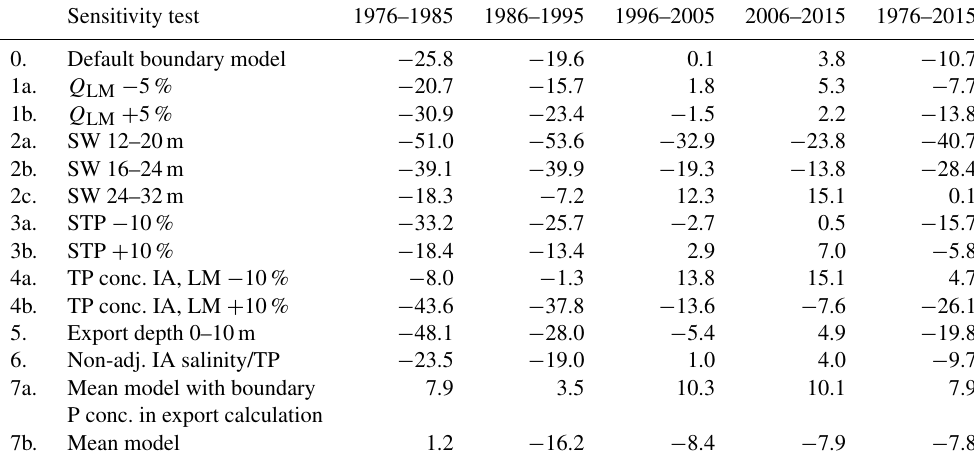
Table 3. Effects of sensitivity tests of net P export (tyr − 1 ) from the inner archipelago (IA) with a boundary model (0–6) and mean model (7). Positive values indicate that the IA accumulates (is net a sink for) P, negative values that it is a net source of P. Year 2011 is excluded. Sensitivity tests included (1) Variable freshwater flow with Lake Mälaren ( Q LM ), (2) recruitment depth of inflowing salt water (SW) from the middle archipelago (affecting salinity and P), (3) sewage treatment plant (STP) discharge of P, (4) water P concentrations in the IA and Lake Mälaren (LM), (5) deeper layer for water export from the IA, (6) non-adjusted data from central IA stations (see methods), (7) mean model.